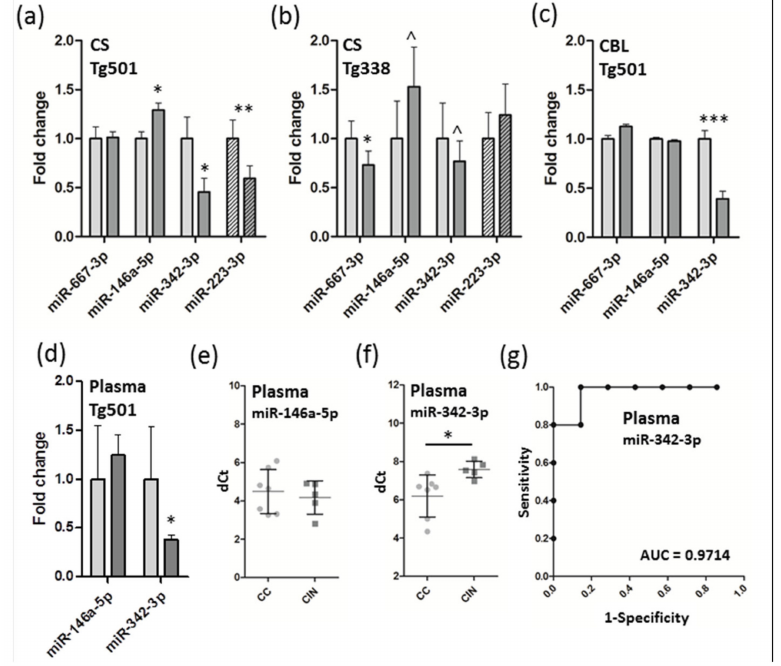
Figure 2. Quantitative PCR of di ff erentially expressed miRNAs in Tg501 and Tg338 mice. Controls and inoculated groups are denoted with light grey and dark grey bars, respectively, whereas solid